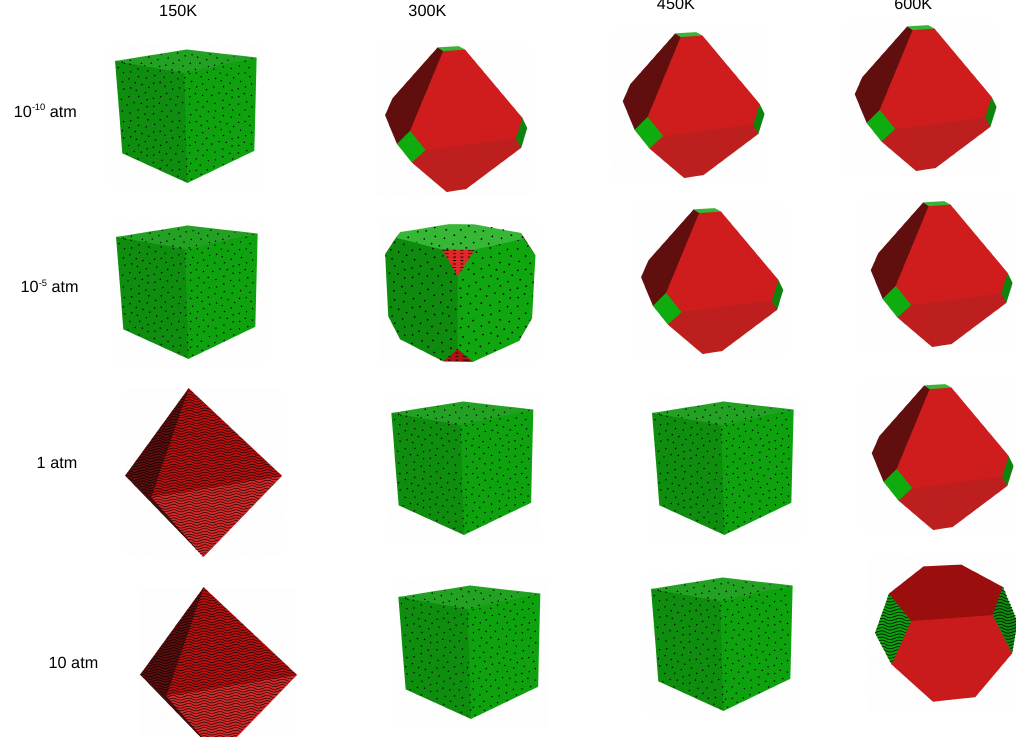
Figure 3. The effect of temperature on the morphology and composition of the CaF 2 crystal at four pressure conditions—surface (111) in red and (100) in green. The clean surfaces are indicated by empty planes, the dotted planes correspond to 100% HF coverage, wavy lines to 50% HF coverage and dashed planes to 25% HF